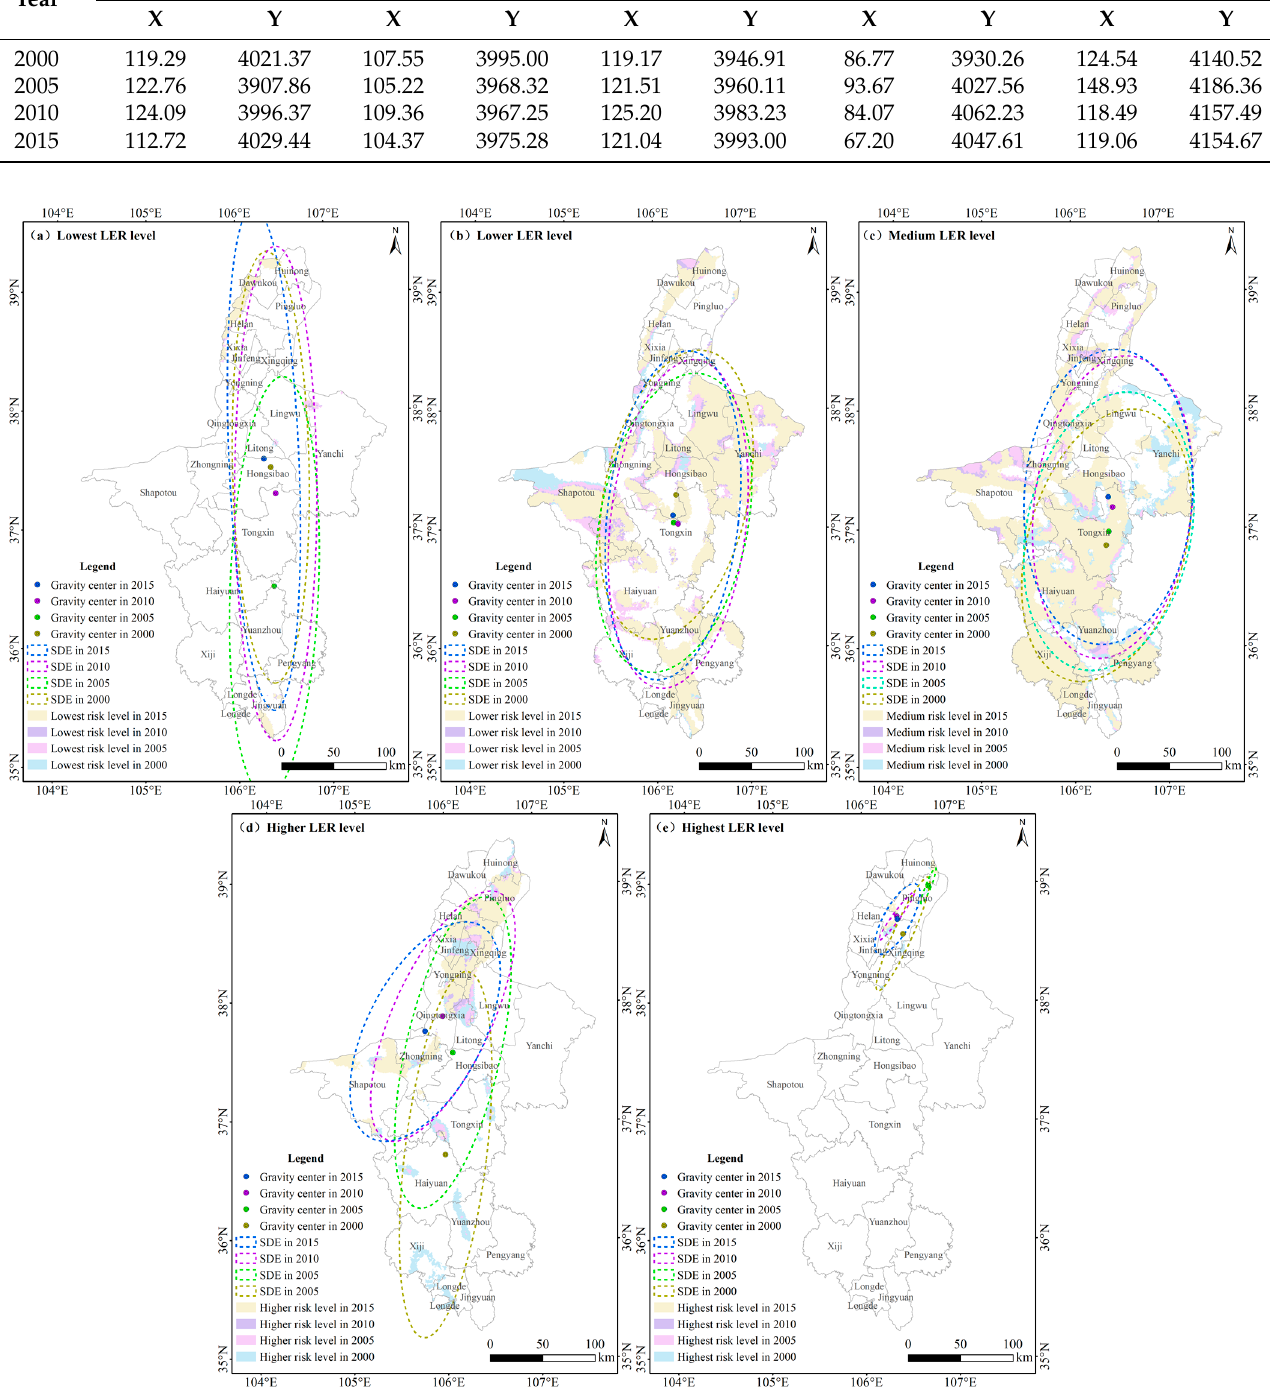
Figure 12. Standard deviation ellipse and gravity center of different LER levels in Ningxia from 2000 to 2015. Table 5. Gravity center coordinates of different landscape ecological levels in Ningxia from 2000 to 2015 (Unit: km).